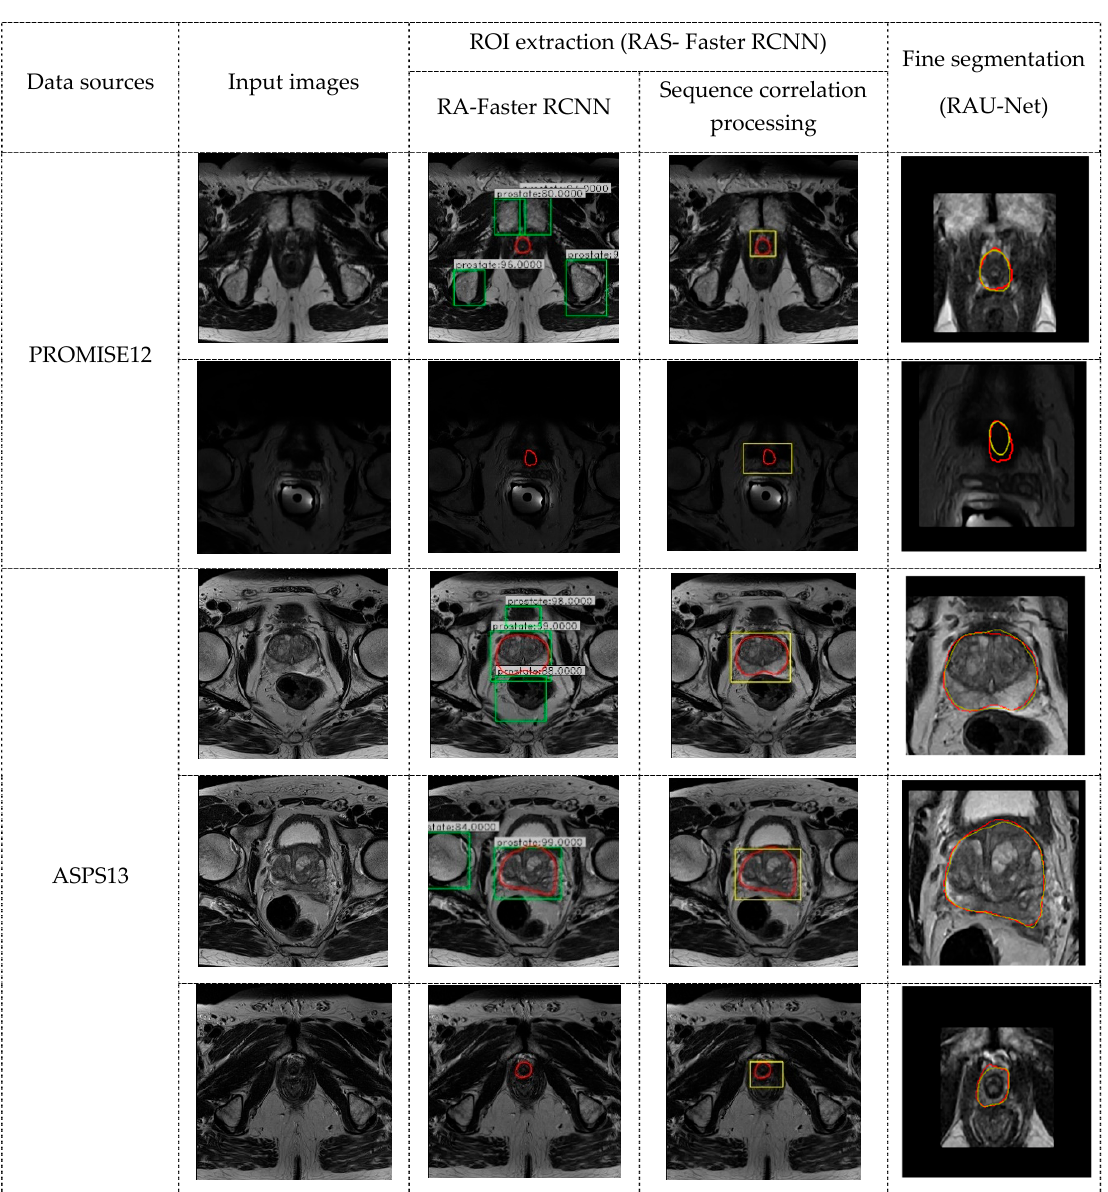
Figure A1. The intermediate results of CDA-Net during the testing of the two data sets